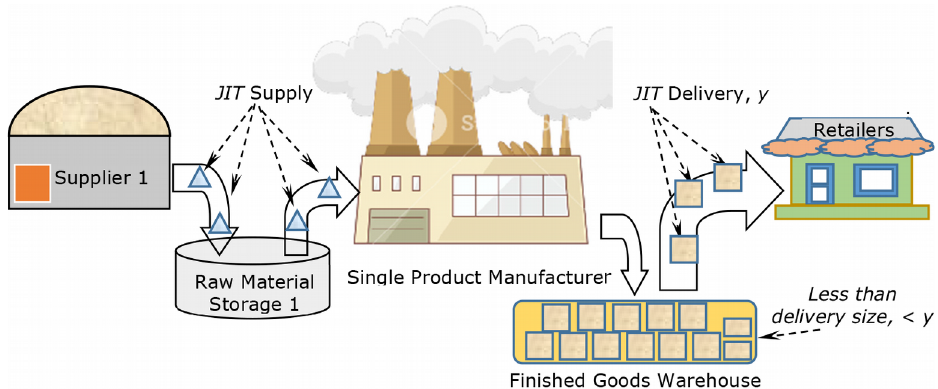
Figure 1. A typical JIT operated supply chain model with imperfect matching